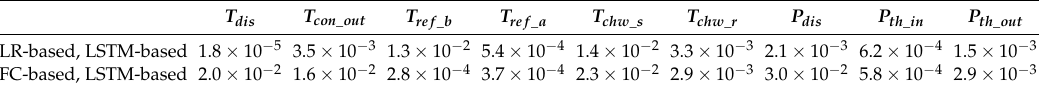
Table 6. P -values between the traditional methods and the proposed method.